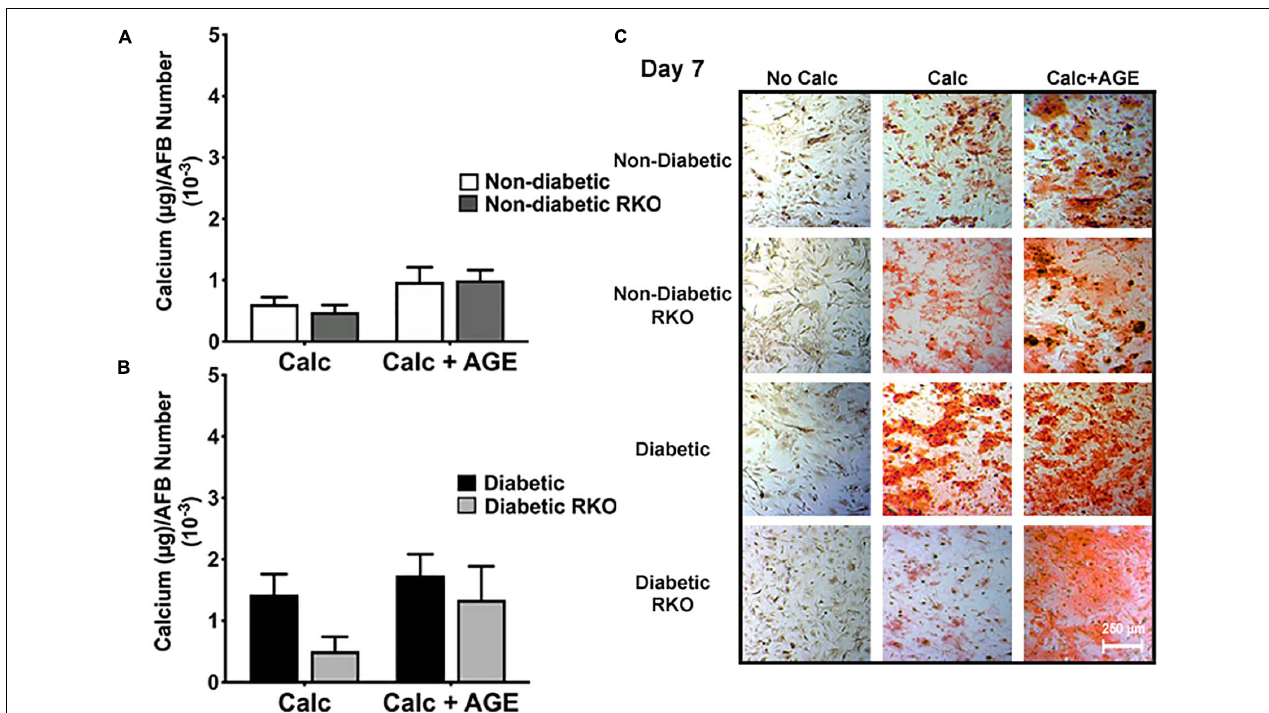
FIGURE 5 | Adventitial fibroblasts (AFBs) calcification is not affected by the presence of RAGE. Primary mouse AFBs were isolated from non-diabetic and diabetic aortas with or without the presence of RAGE. AFBs were plated onto 96 well plates and treated with 3 mM P i with or without AGEs (0.5 mg/mL) for 7 days. (A,B) Calcium ( µ g) was normalized to cell number and graphed as mean ± SEM with n = 6–9 of independent replicates. (C) Alizarin red staining indicated calcification by the red staining. (4X and scale bar = 200 µ M) Statistical analysis consisted of a one-way ANOVA and a Fisher’s LSD test post hoc